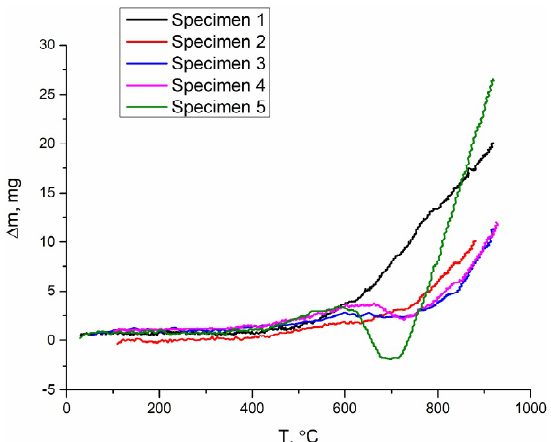
Fig. 1. TG data obtained for Specimens 1-5 in air.